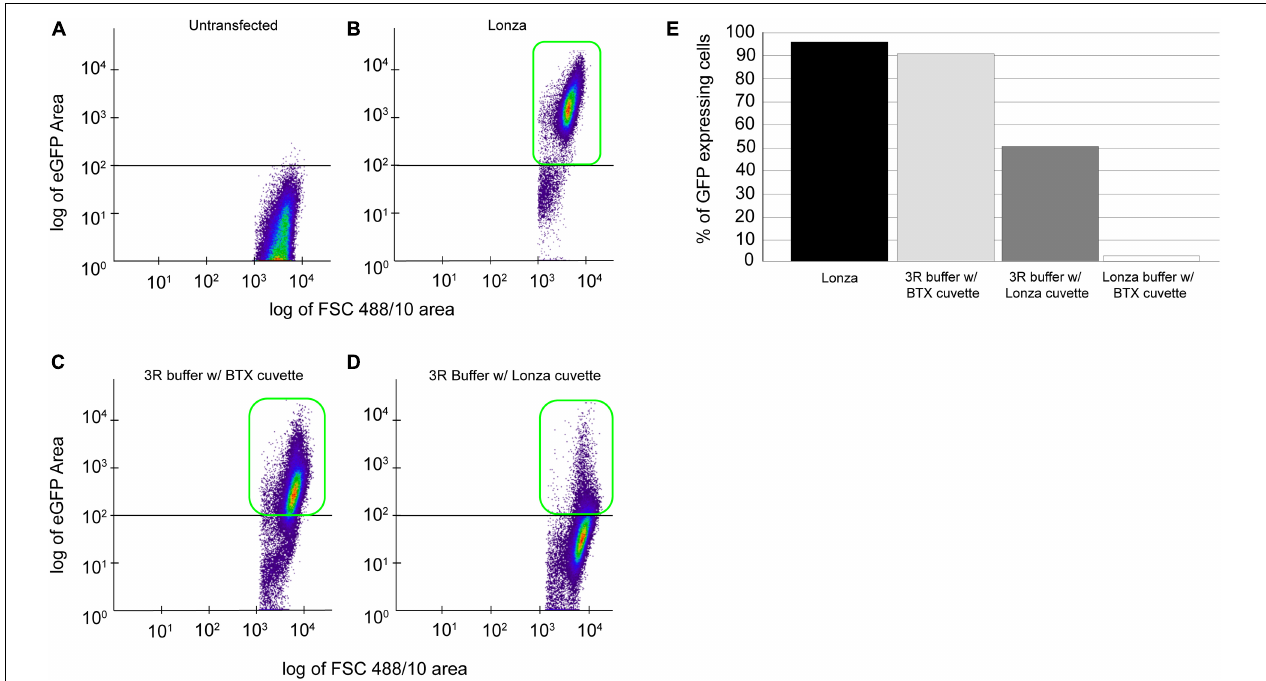
FIGURE 2 | Comparison of proprietary and non-proprietary transfection. Cells, 25 × 10 6 cells transfected with 20 µ g of p PmMOE[MOE1]:GFP plasmid using proprietary and non-proprietary protocols. (A) Flow cytometry scattered plot of untransfected (wild-type) cells, no GFP expression detected. (B) The scattered plot of flow cytometry, identifying GFP-positive cells in transfection performed using the proprietary Lonza method. (C) Scatterplot representation of GFP-positive cells in transfection performed using 3R buffer and BTX cuvette. (D) Scatterplot showing the GFP-positive cells when transfected with 3R buffer utilizing Lonza cuvette. (E) Bar graph showing the % of GFP-positive cells when transfected with the Lonza system (black bar), 3R buffer in combination with BTX cuvette (gray bar), 3R buffer using Lonza cuvette (dark gray), and Lonza buffer with BTX cuvette (white